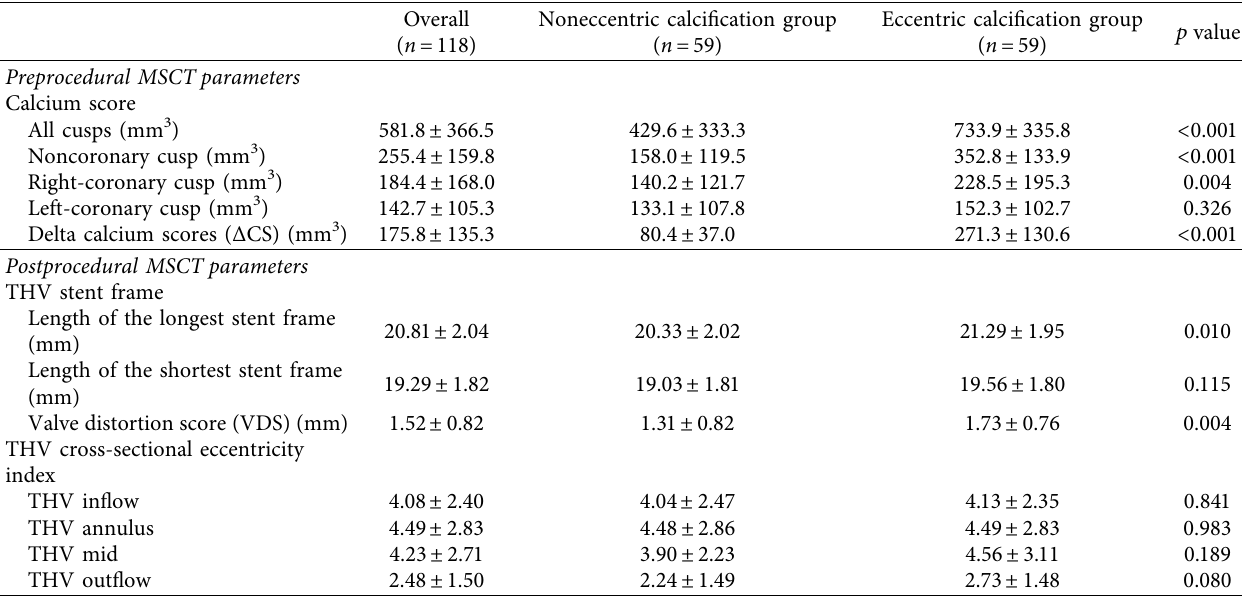
Table 2: Multislice computed tomography results.